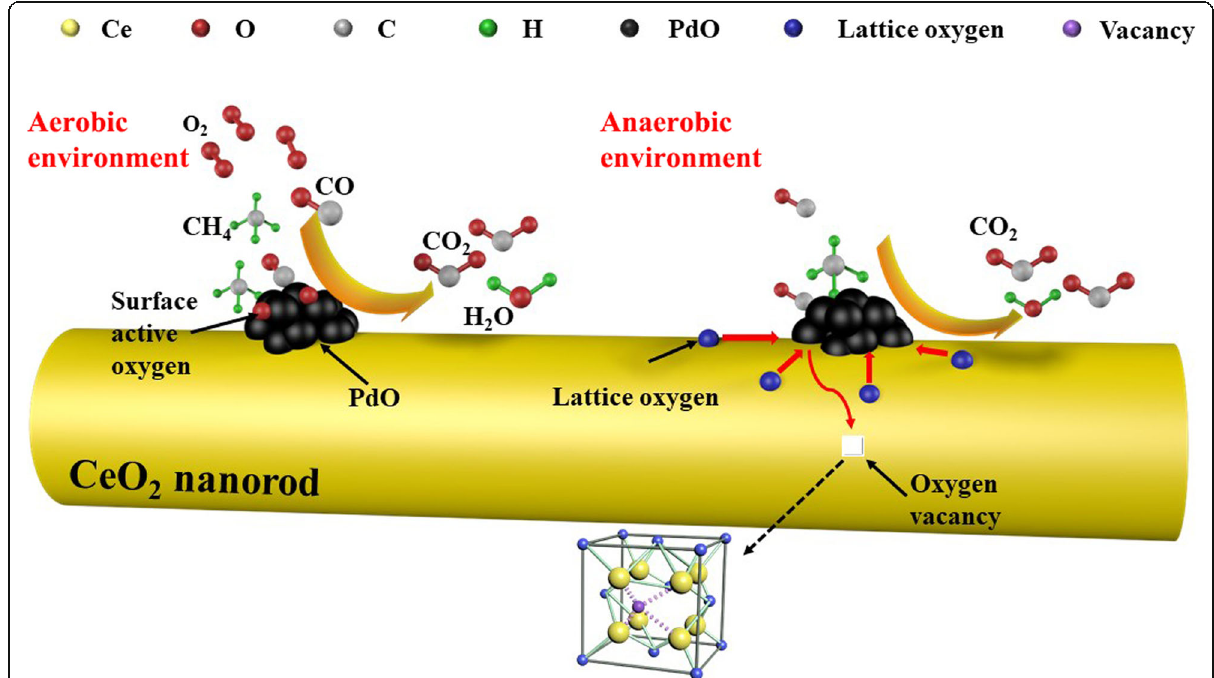
Fig. 11 Schematic illustration of CO oxidation and methane combustion over the rod-like nanoporous PdO/CeO 2